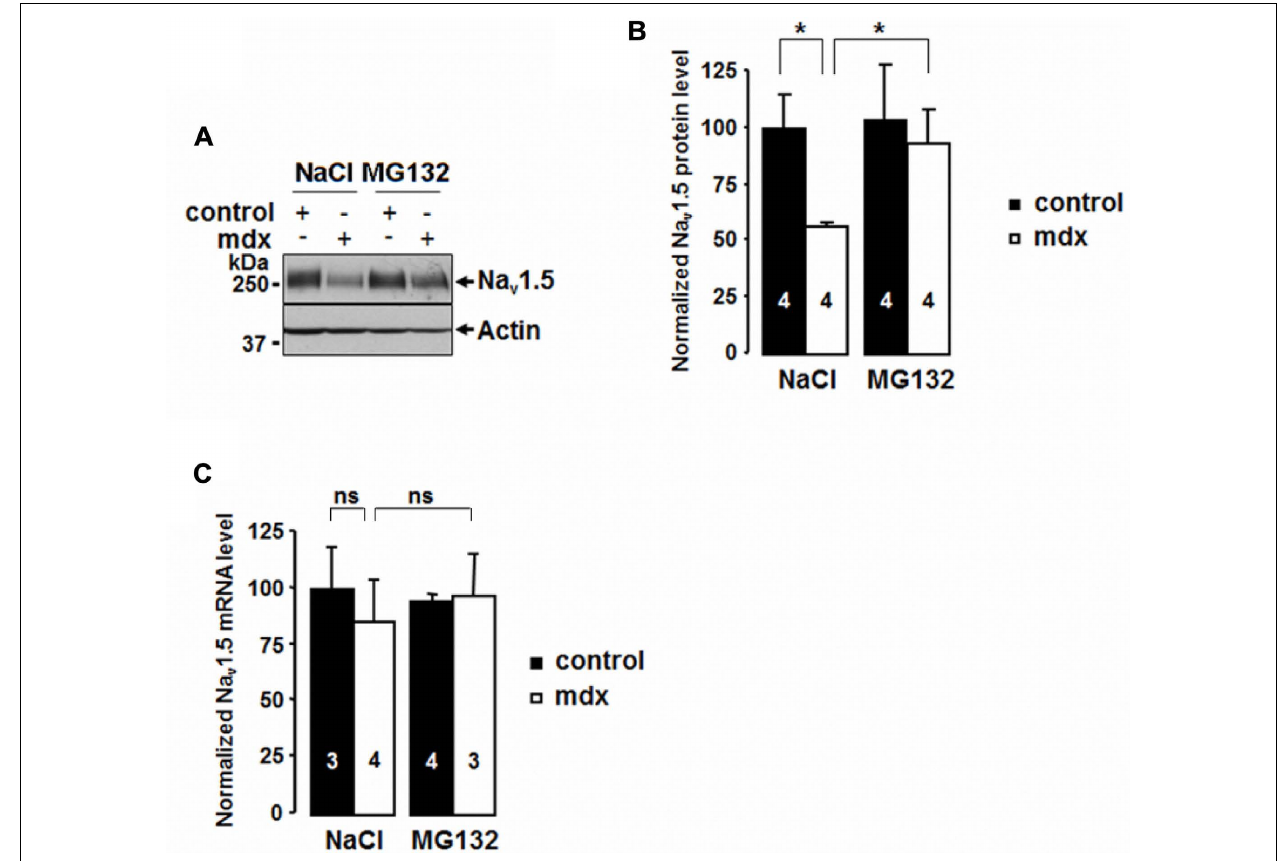
FIGURE 1 | Effects of MG132 treatment on Na v 1.5 protein content and mRNA level. (A) RepresentativeWestern blot of ventricular myocyte lysates of control and mdx 5cv mice treated with MG132 or 0.9% NaCl as indicated. Eighty micrograms of lysate were loaded in each lane. (B) Bar graph representing the amounts of total Na v 1.5 protein in control and mdx 5cv